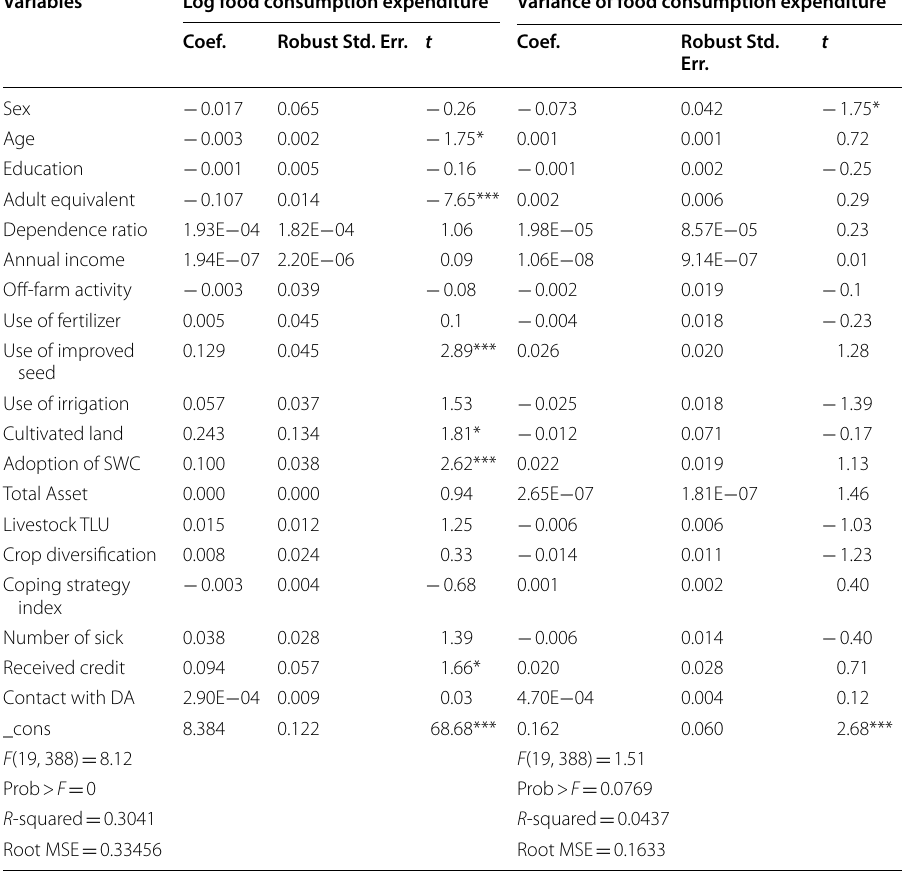
***, ** and * significant at the 1, 5, and 10% probability levels, respectively